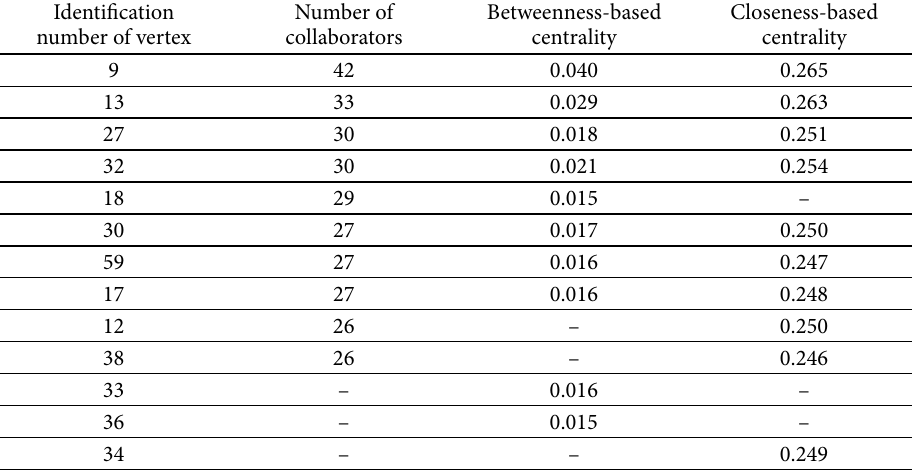
Table 6. Important vertexes from the centrality perspective in the NBI network Identification number of